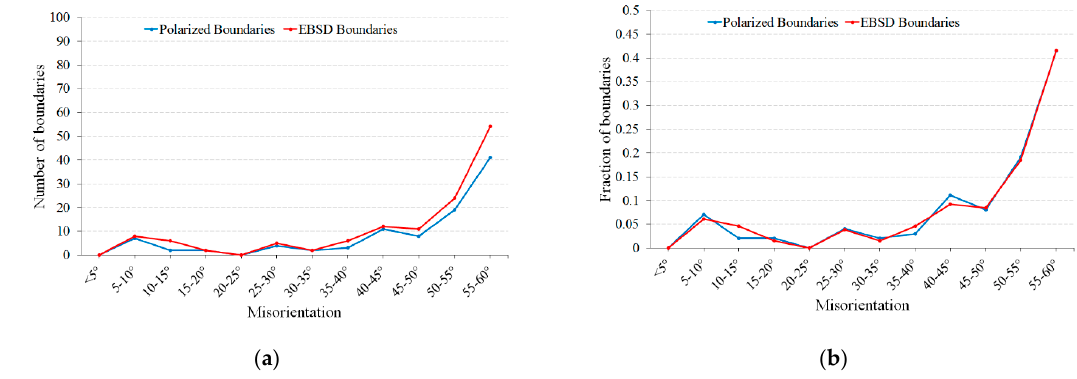
Figure 8. Number of identified boundaries ( a ) and fraction of boundaries ( b ) based on the misorientation angles, thixocast sample.